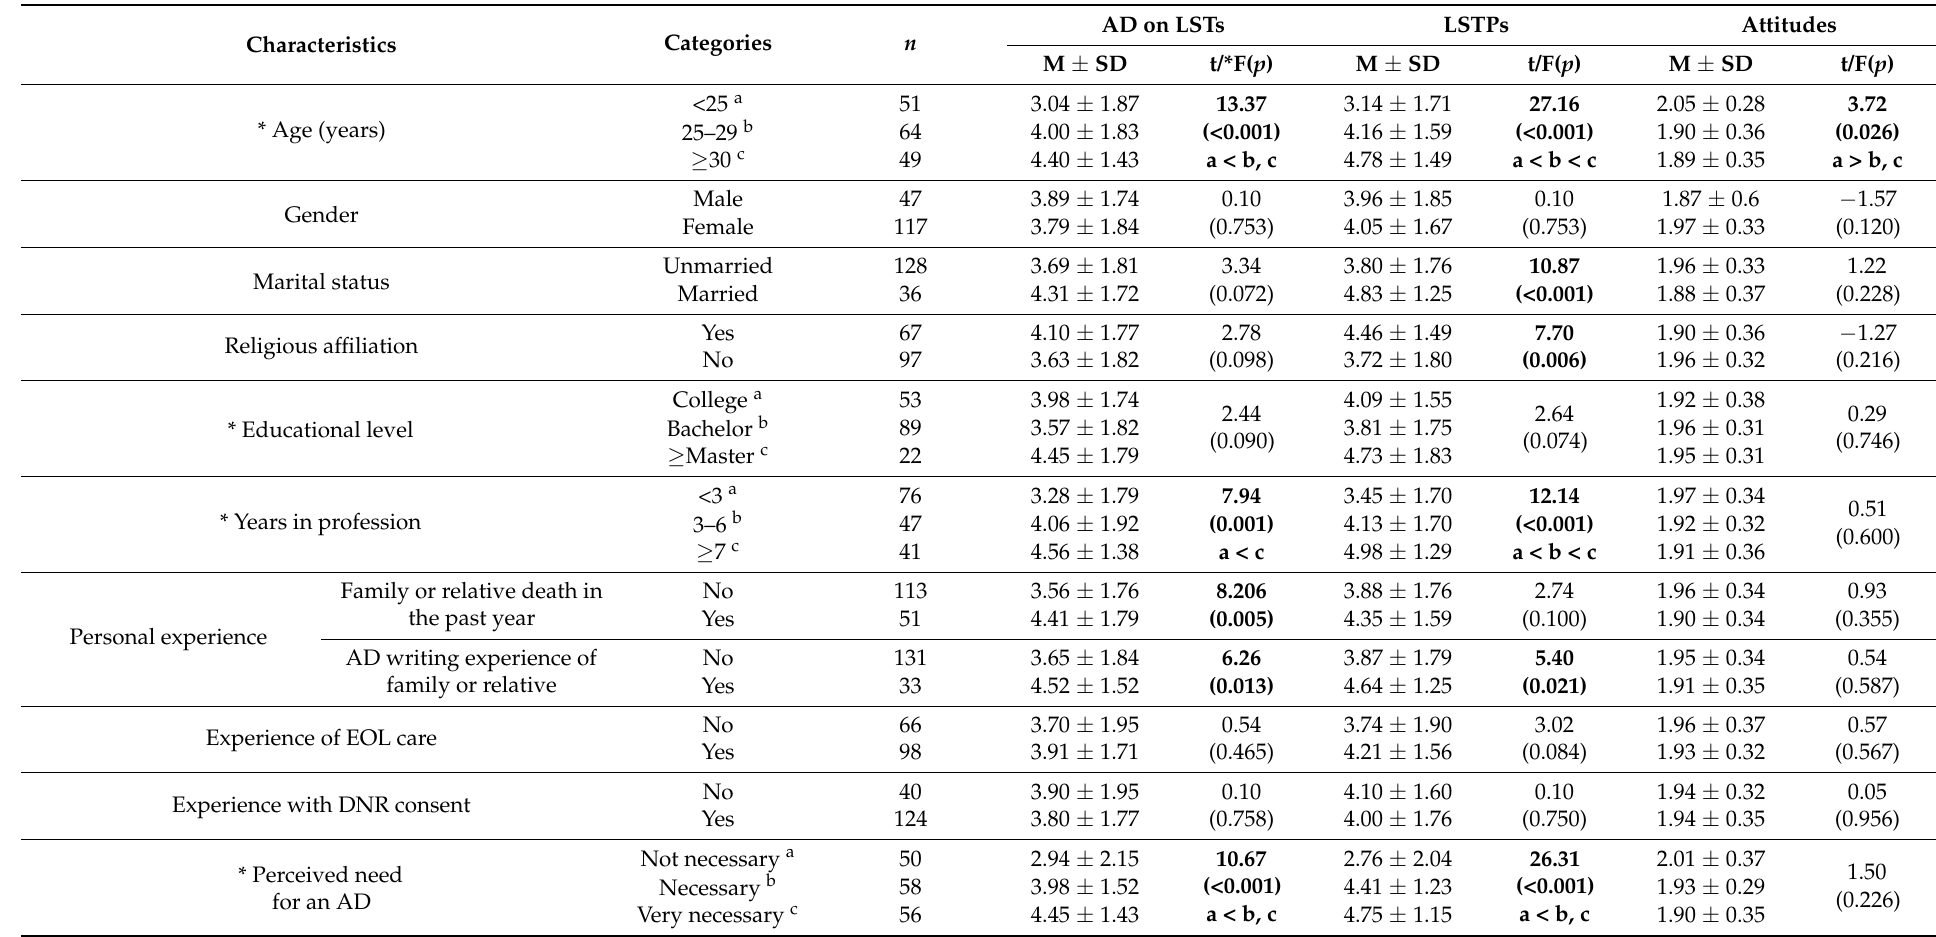
Table 4. Demographic differences in knowledge about and attitudes toward ADs of emergency healthcare providers ( n = 164).